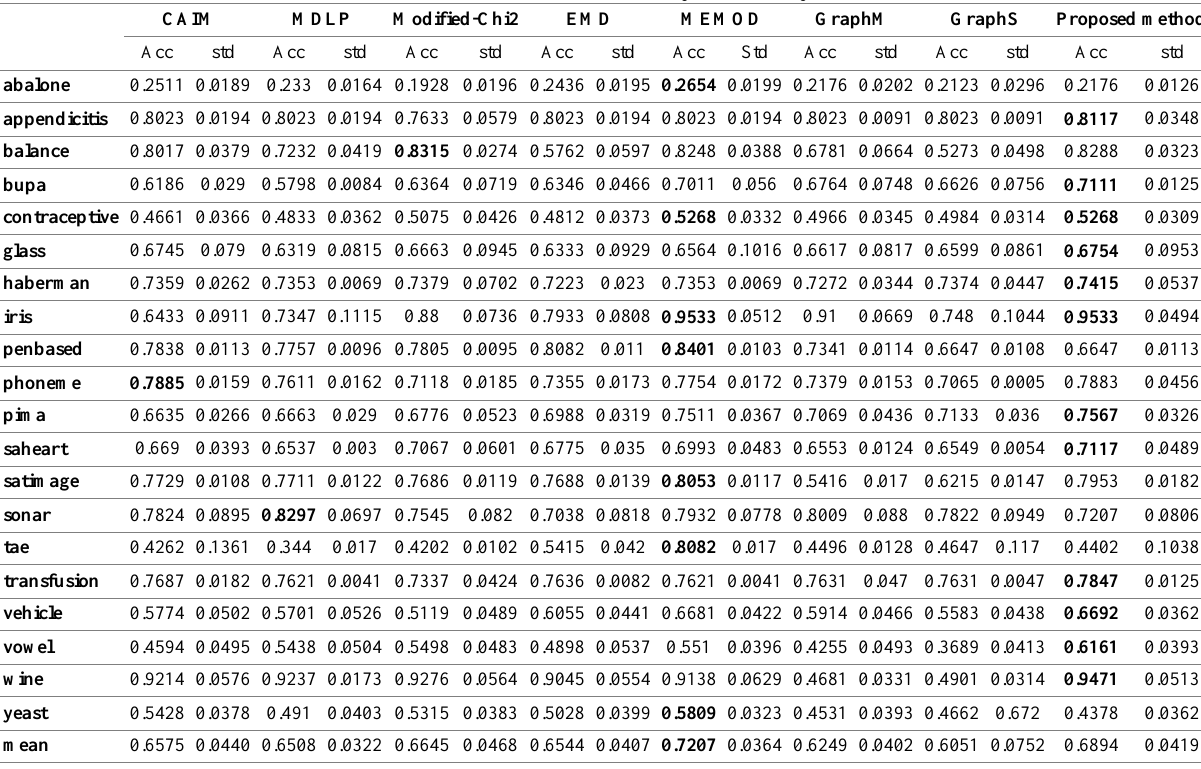
Table 5. The Classification accuracy obtained by